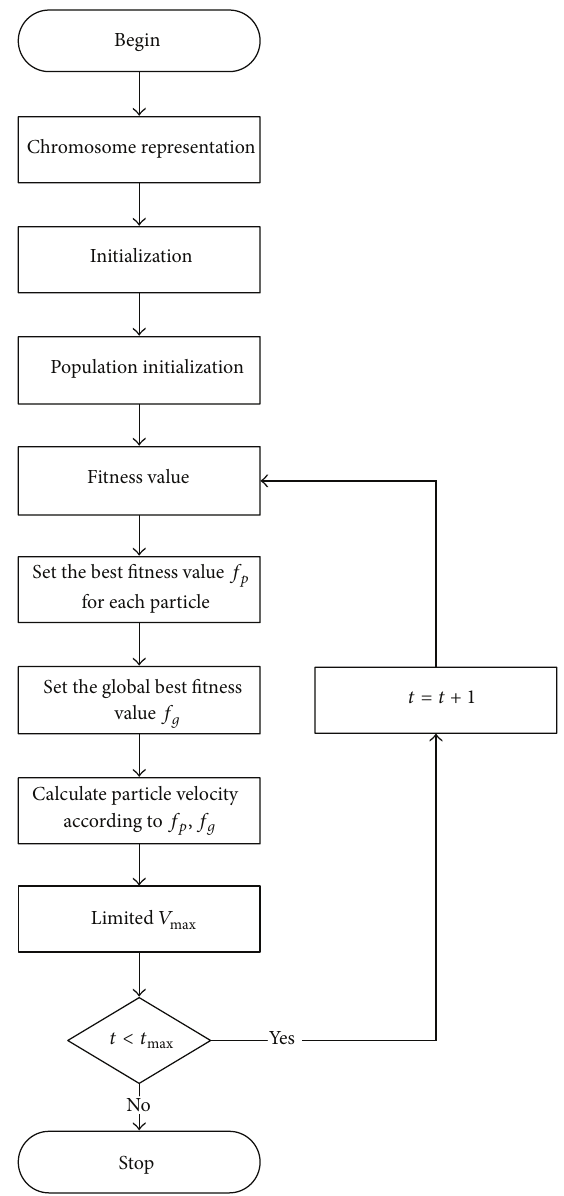
Figure 6: Flow chart of the Particle Swarm Optimization